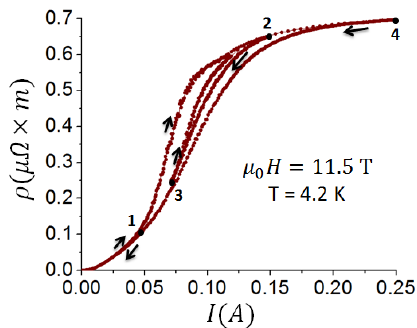
Fig. 4. RCCs for the cold-rolled Nb-Ti tape. The magnetic field (11.1 Т and 11.4 T) is normal to the tape. Upper critical field for this geometry is μ 0 H c2 =11.6 T